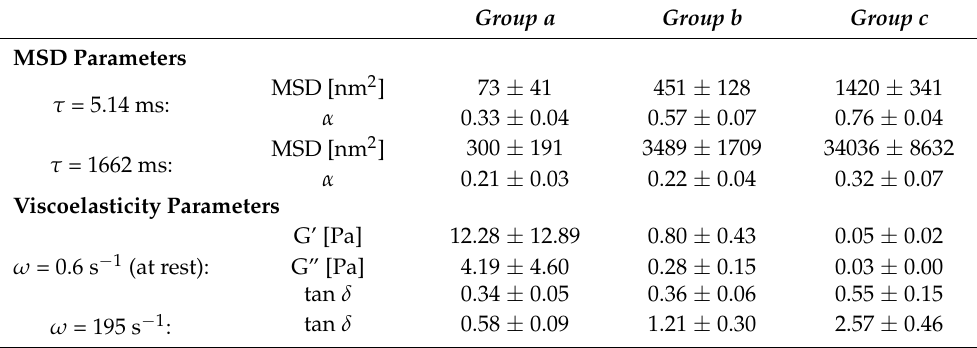
Table 2. Characteristic mean parameters of the MSDs and viscoelasticity. MSD parameters: absolute MSD and diffusive exponent at the evaluation limits τ = 5.14 ms and τ = 1662 ms. Viscoelasticity parameters: Storage modulus G’, loss modulus G” and tan δ at ω = 0.6 s − 1 (at rest) and tan δ